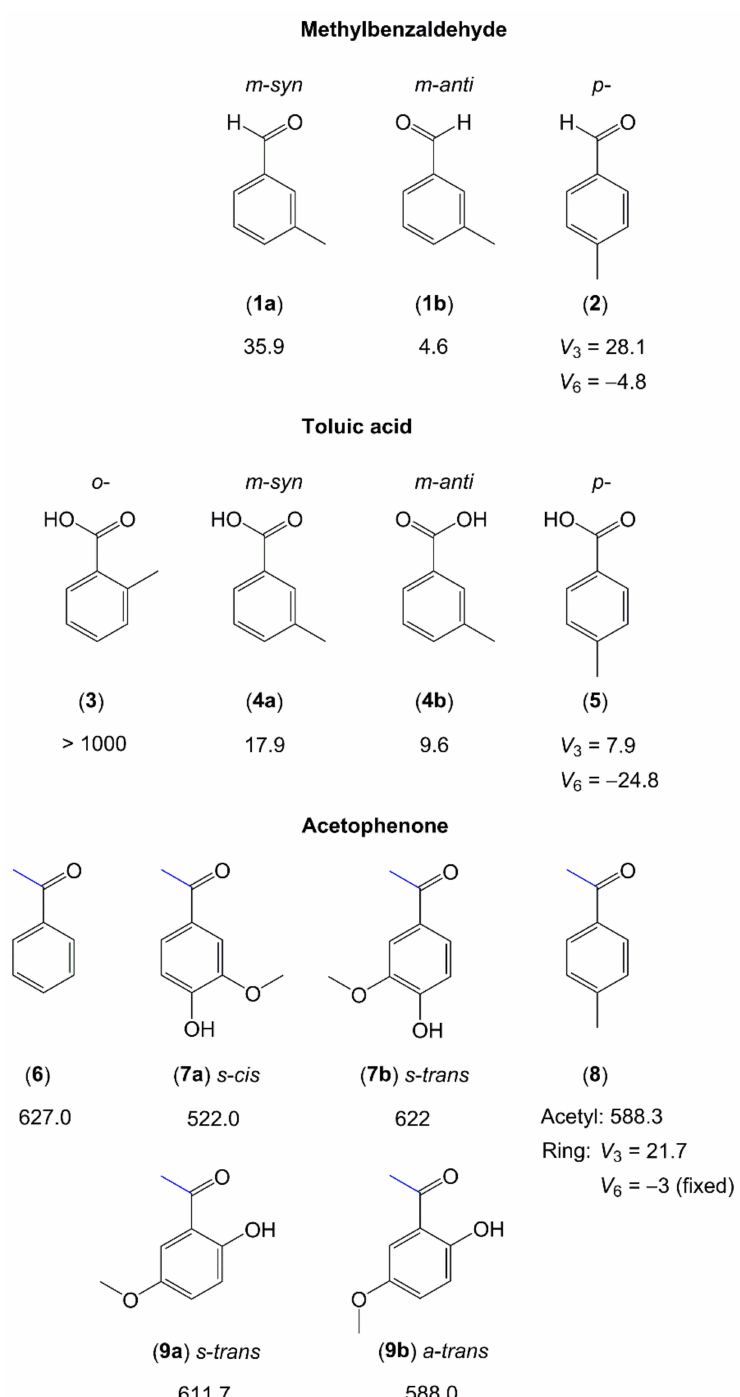
Figure 6. Barriers to methyl internal rotation in toluene derivatives with a carbonyl-containing substituent (in cm − 1 ). ( 1 ) m-Tolualdehyde [154], ( 2 ) p-tolualdehyde [155], ( 3 ) o-toluic acid [156], ( 4 ) m-toluic acid [157], ( 5 ) p-toluic acid [65], ( 6 ) acetophenone [158], ( 7 ) acetovanillone [159], ( 8 ) 4-methylacetophenone [77,160], ( 9 ) 6-hydroxy-3-methoxyacetophenone [159]. Resembling cresols and methylanisoles (see Section 2.1.2.2 and Figure 5), microwave studies on three isomers of toluic acid have shown that the V 3 potential is so high in the o-isomer (molecule ( 3 ) in Figure 6) that no torsional splittings could be observed [156]. The barrier to methyl internal rotation drastically decreases in the meta- [157] and para- isomers [65]. m-toluic acid ( 4 ) [157] and m-methylbenzaldehyde ( 1 ) [154] both exist in